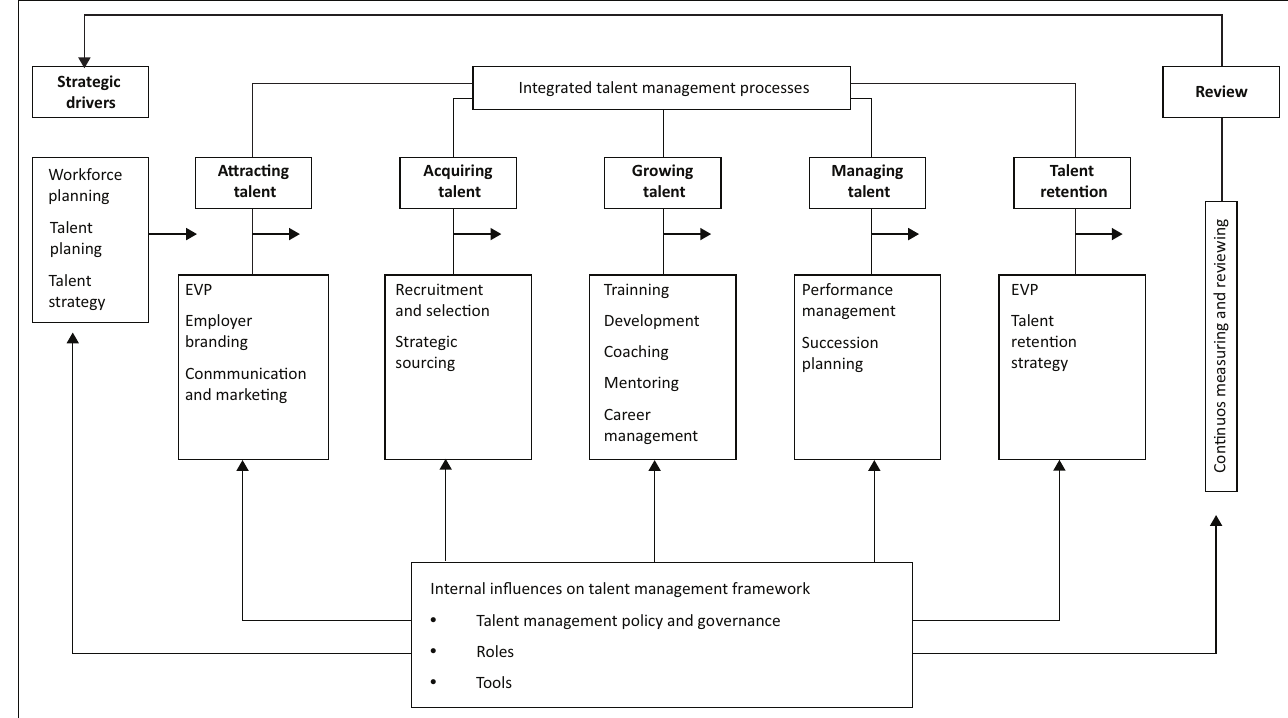
FIGURE 2: A framework for talent management in the higher education